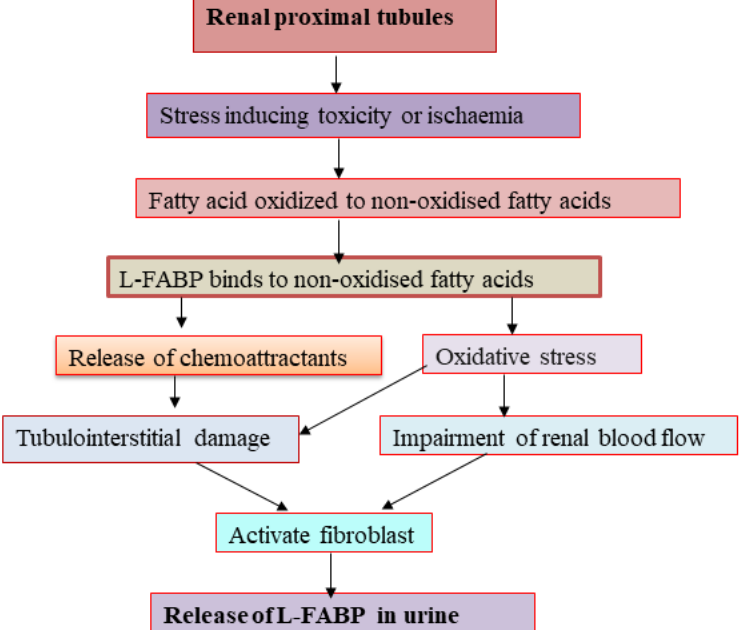
Figure 3. Mechanism of acute kidney injury related L-FABP release through urine at the time of tubular injury. tubular